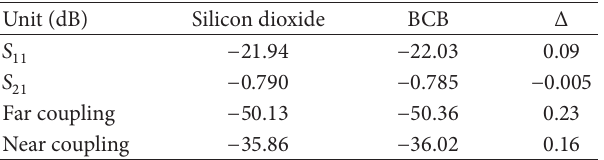
Table 4: 𝑆 parameter comparison at 20